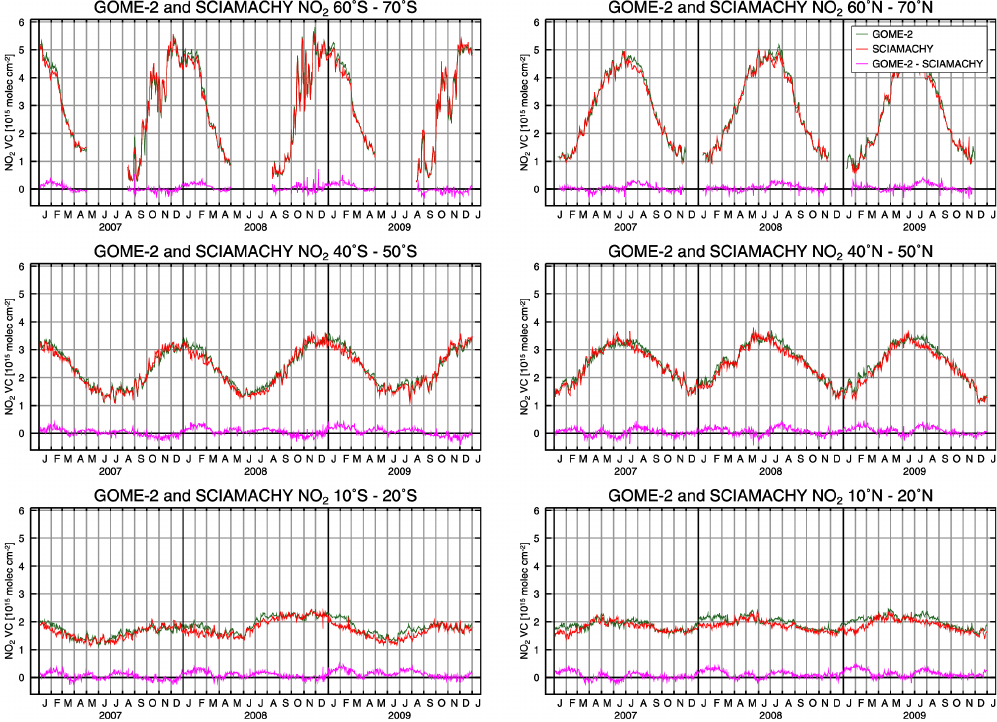
Fig. 11. Comparison of three years of daily GOME-2 (green) and SCIAMACHY (red) NO 2 over the Pacific (180 ◦ E–220 ◦ E) for selected 10 ◦ latitude bands in the southern (left) and northern hemisphere (right). A stratospheric airmass factor was applied to both data sets. Also shown is the difference GOME-2 – SCIAMACHY